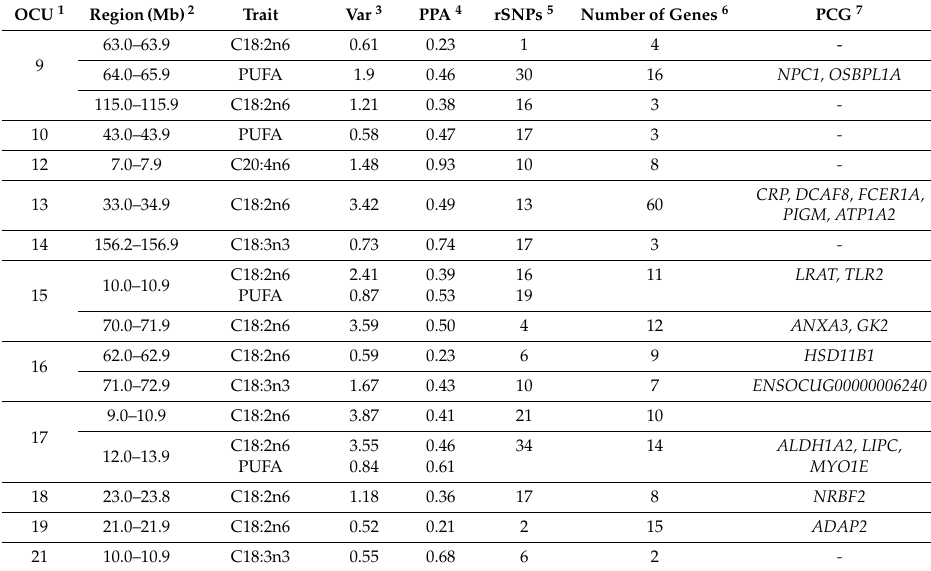
1 Rabbit chromosome, 2 associated region, 3 percentage of the genomic variance explained by the windows belonging to the associated region, 4 posterior probability of association, 5 number of relevant SNPs with a Bayes factor higher than 10 in the extended region, 6 number of the protein coding genes in the extended region. 7 putative candidate genes related to lipid metabolism retrieved from DAVID database, PUFA: polyunsaturated fatty acids stand for the Genomic regions associated with PUFA / SFA, MUFA / SFA, and n-6 / n-3 of Longissimus thoracis et lumborum in